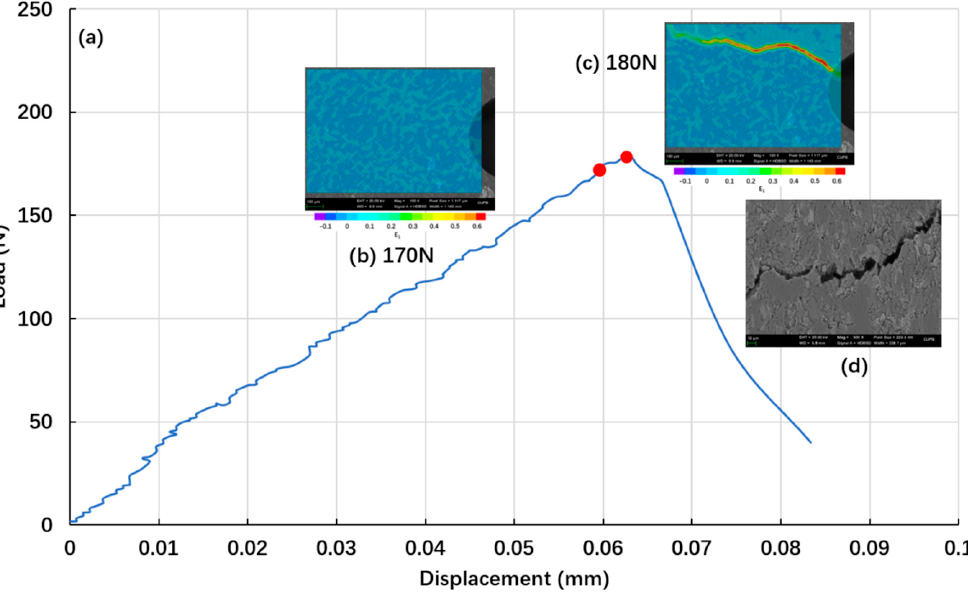
Figure 9. Cracking process in Group D − 2: ( a ) load–displacement curve for Group D − 2; ( b ) E 1 cloud chart at a load of 170 N; ( c ) E 1 cloud chart at a load of 180 N and ( d ) zoomed out SEM image of the crack.